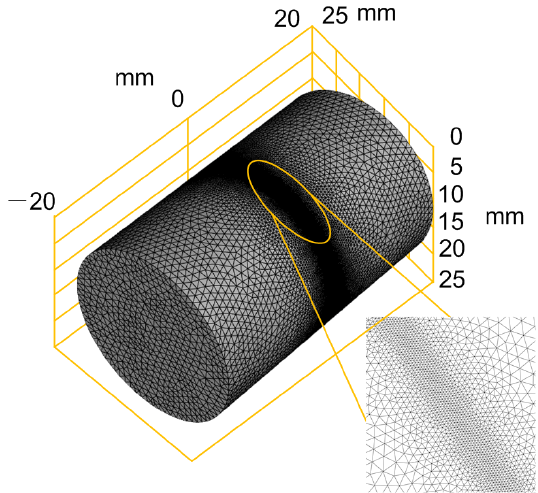
Figure 6. Component structure with mesh.